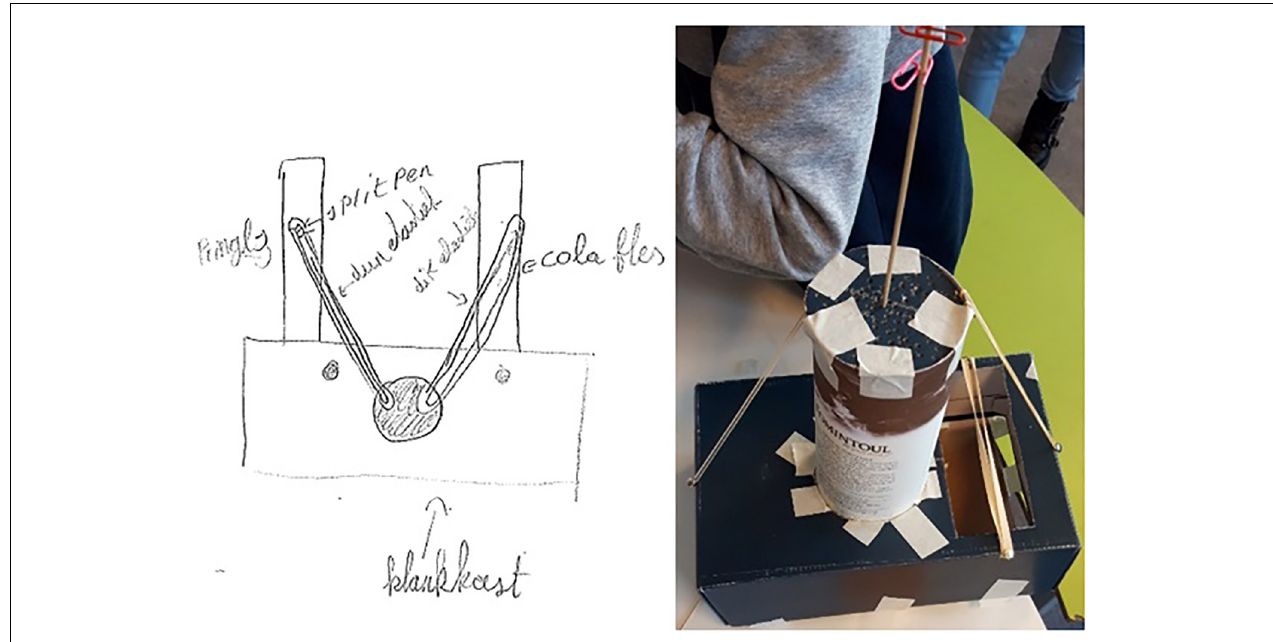
FIGURE 2 | Example of design sketch and corresponding